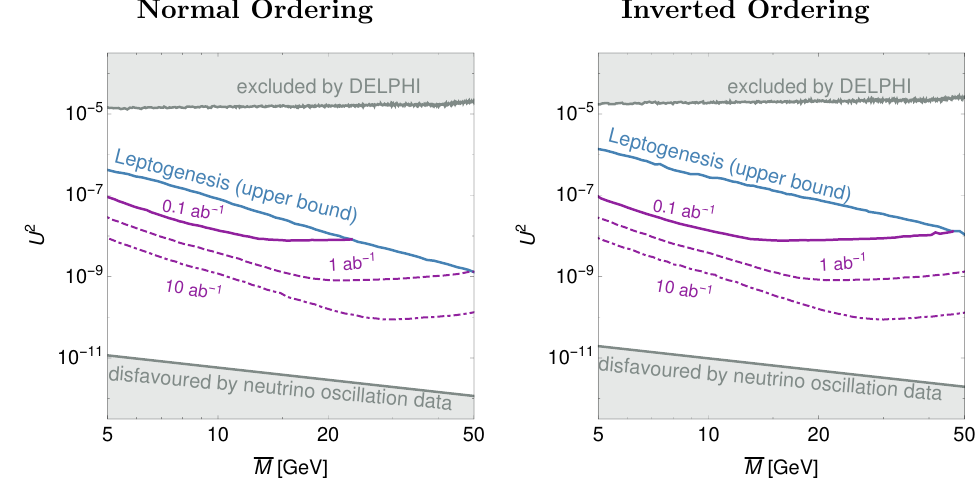
Figure 6 . The blue \BAU" line shows the largest possible U 2 for which the BAU can be generated for given (cid:22) M , as found in the parameter scan described in section 3.3. The purple lines lines mark the parameter regions in which the CEPC experiment can observe at least four expected displaced vertex events from N i with properties that are consistent with successful leptogenesis. The solid line corresponds to the currently planned run, the dashed line corresponds to the equal Z-pole running time as is currently planned by FCC-ee, while the dot-dashed line corresponds to what is possible with the crab waist technology. The grey area is disfavoured by DELPHI (on the top) and the neutrino oscillation data (at the bottom). We show no lower bound on U 2 from leptogenesis because it is lower than the constraint from neutrino oscillation data in this mass range. More details are given in the main text, cf. section